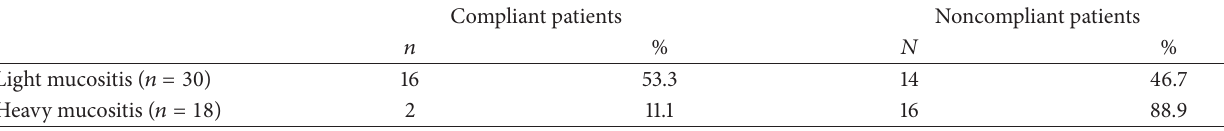
Table 4: Severity of mucositis with respect to